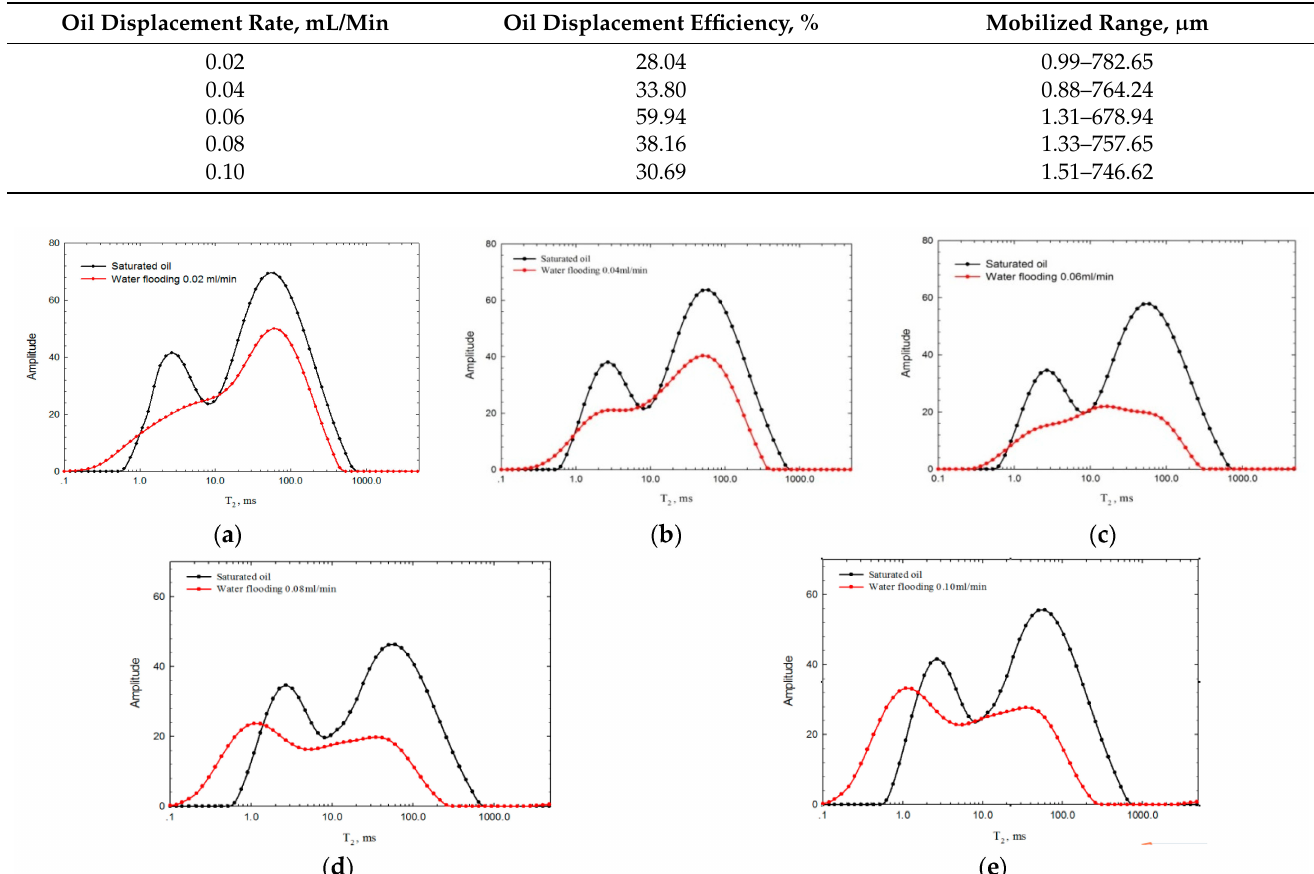
Table 2. Results of oil displacement experiment.